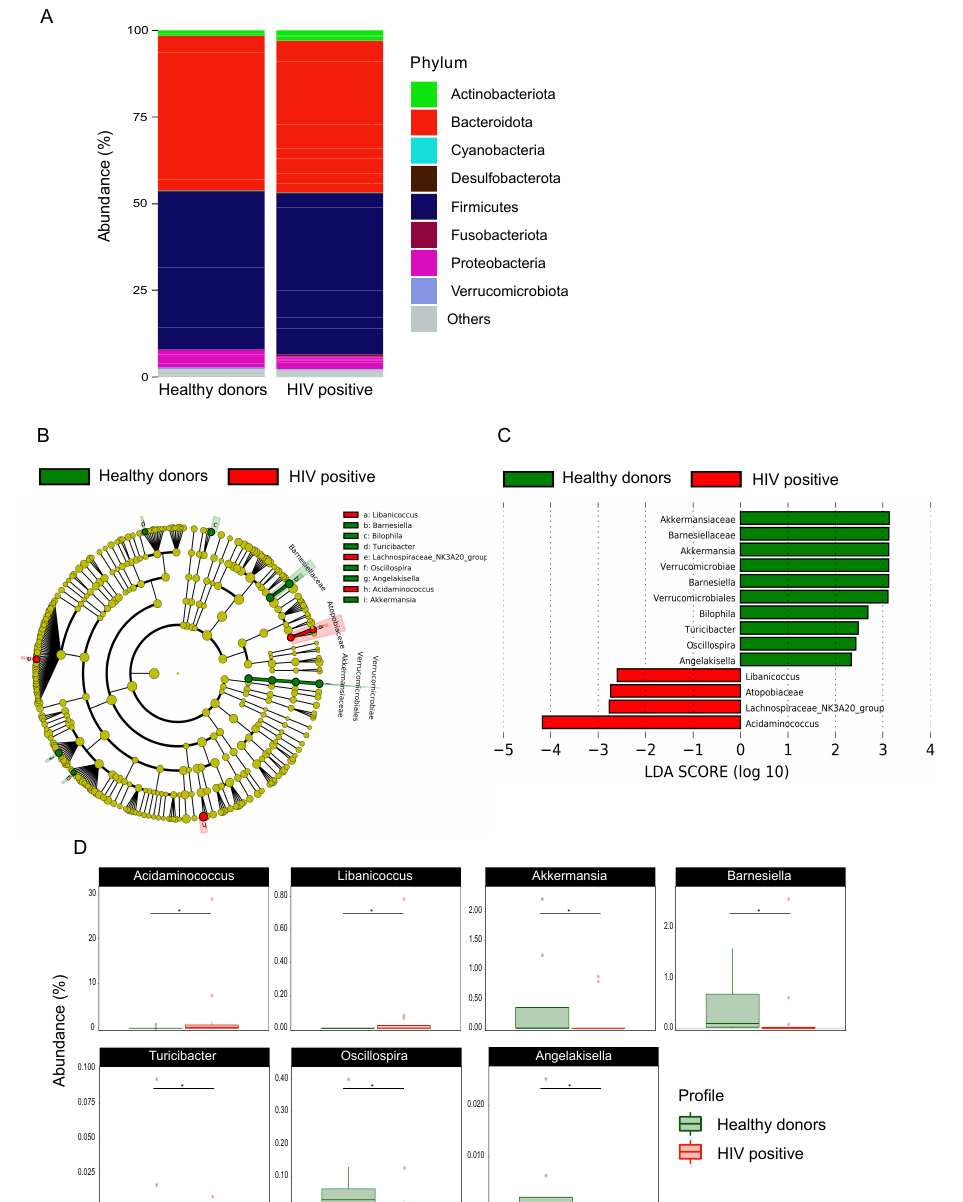
Figure 1. Taxonomic differences in fecal microbiota between HIV-1 positive patients and healthy donors. Relative abundance at phylum level ( A ); Cladogram of LefSe linear discriminant analysis (LDA) scores showing differentially abundant taxonomic clades with an LDA score >2.0 in the gut microbiota of HIV-1 patients and healthy donors ( B ); LDA scores of differentially abundant taxa in the gut microbiota of HIV-1 patients and healthy donors ( C ). The relative abundance of genera identified by LefSe as being differentially abundant in HIV-1 patients and healthy donors were compared using a Mann–Whitney test ( D ). * p <